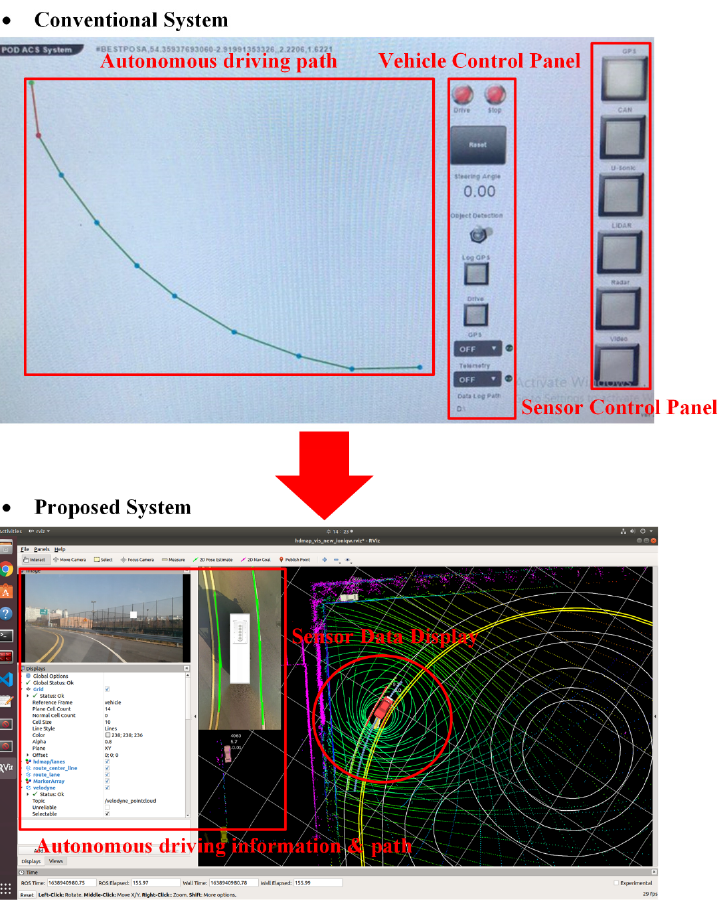
Figure 17. A Comparison of Conventional and Proposed Autonomous Driving Systems in Imple- mentation.